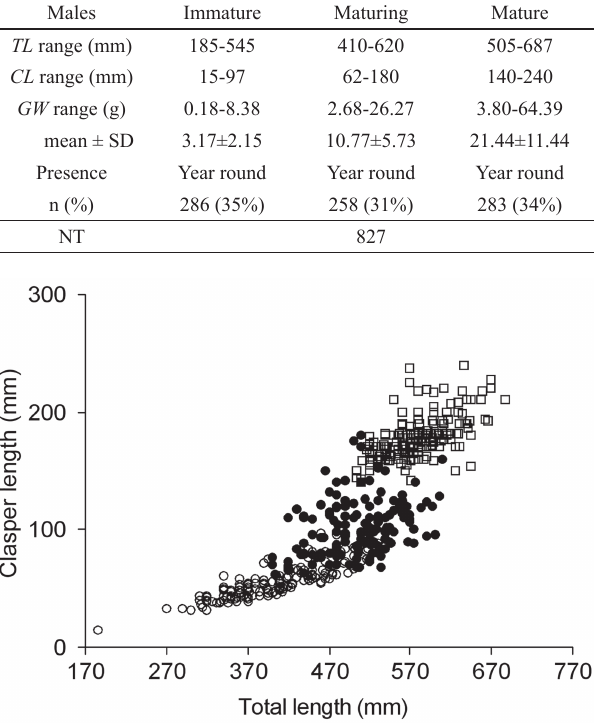
Fig. 3. Total length (TL) and clasper length (CL) relationship of Sympterygia bonapartii from San Matías Gulf (Argentina). Immature (○) n = 166, maturing (●) n = 145 and mature (□) n = 193.